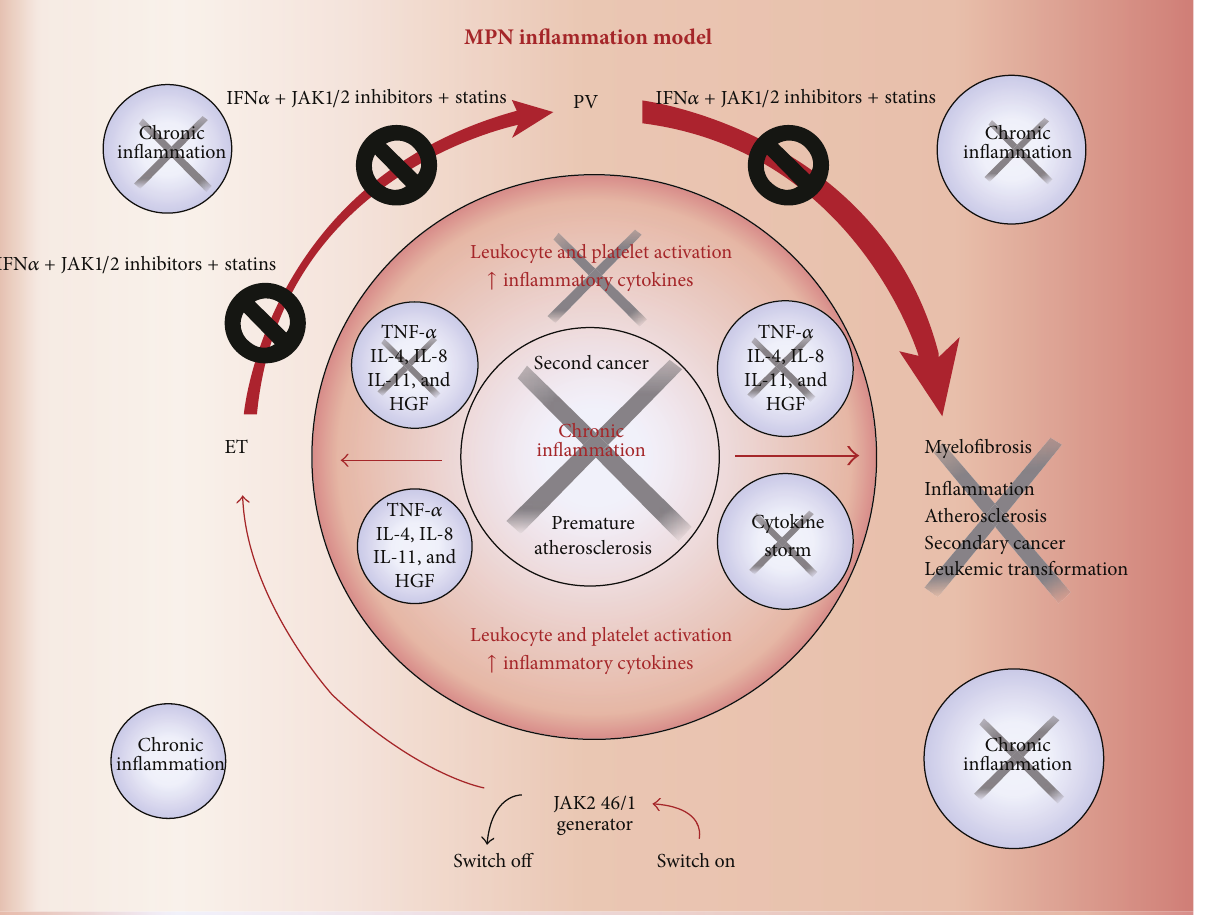
Figure 1: Vicious cycle of inflammation in the biological continuum of ET, PV, and MF. Chronic inflammation is proposed as the trigger and driver of clonal evolution in the biologic continuum from early disease state (ET/PV) to a more advanced disease state (MF). It is possible that combination therapy, using low doses of agents such as interferon-alpha, Janus kinase inhibitors, and statins at the early disease stage, will positively influence the vicious cycle of disease progression. HGF: hepatocyte growth factor; IL: interleukin; MPN: myeloproliferative neoplasm; and TNF: tumor necrosis